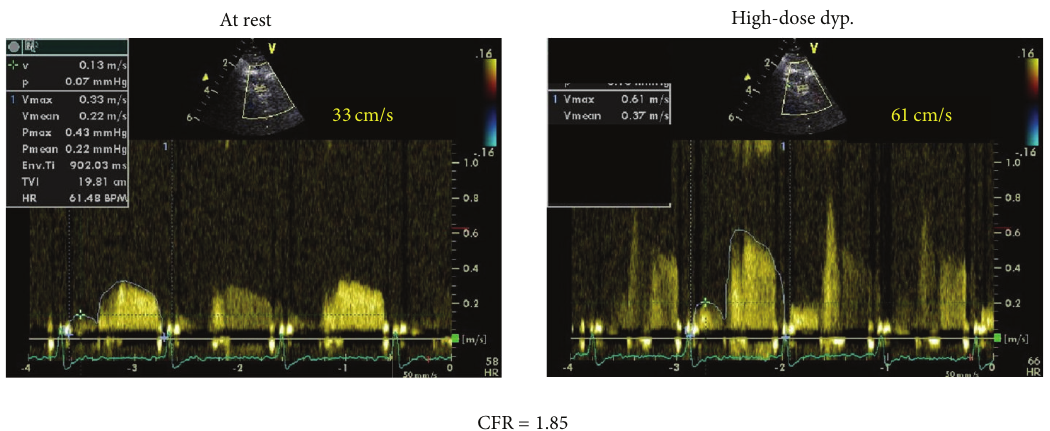
Figure 3: High-dose dipyridamole induced CFR during the same stress echocardiography of Figure 2. At rest